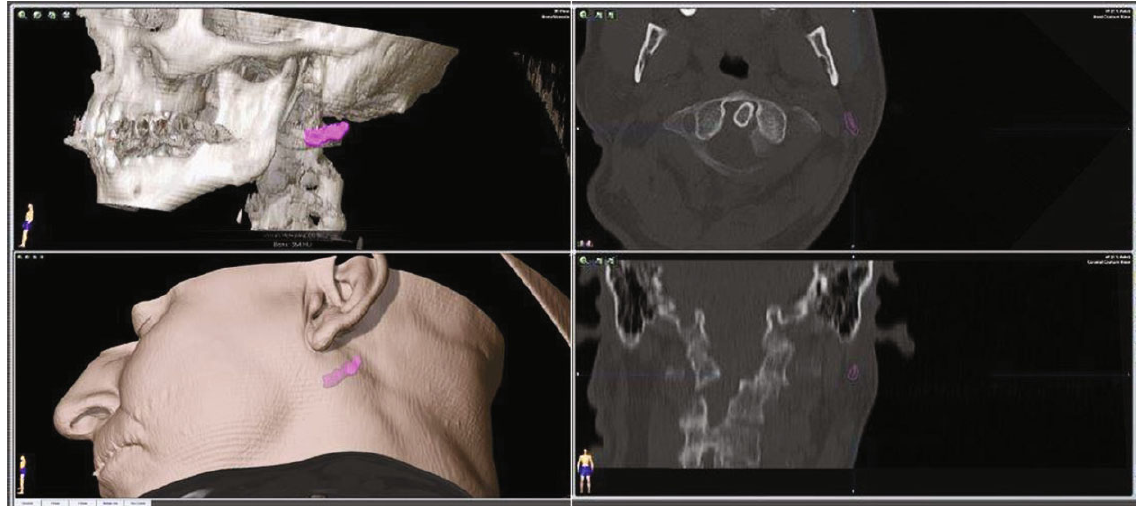
Figure 2: 3D-location of the fractured hypodermic